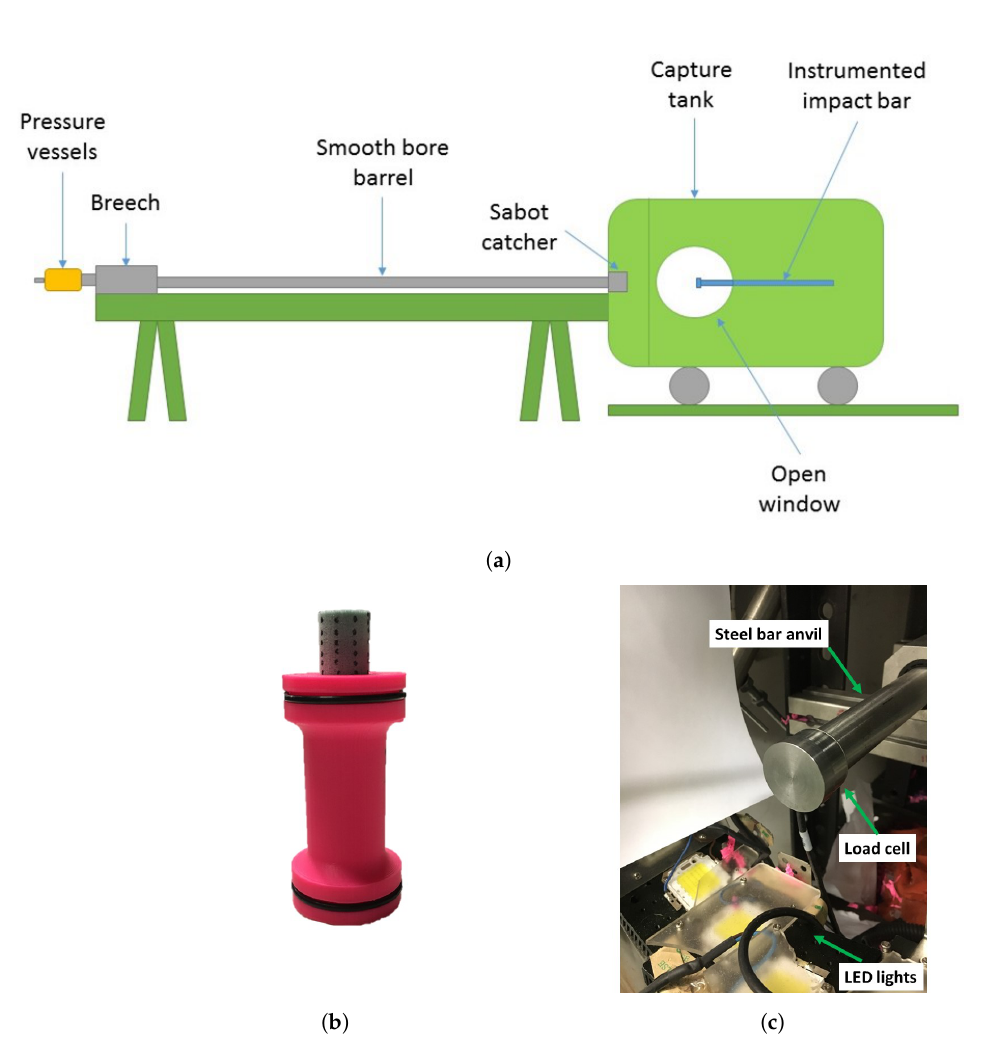
Figure 3. ( a ) Imperial College 50 mm gas gun; ( b ) sabot/specimen system for dynamic compression tests; ( c ) tip of the impacted steel